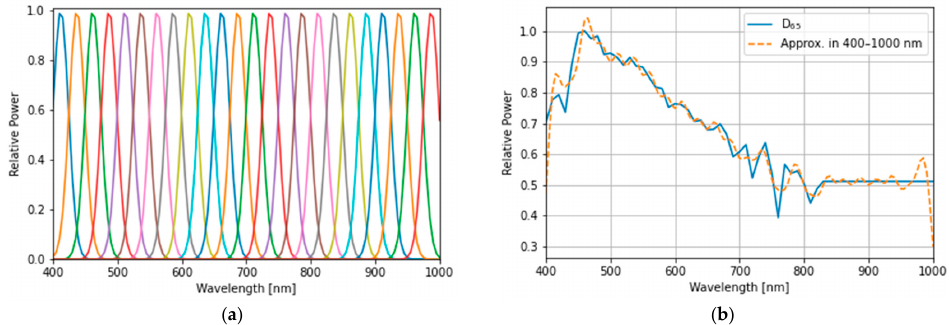
Figure 6. Sets of SPDs with real light-emitting diodes (LEDs): ( a ) measured SPD of 24 LEDs for sub- lights, and ( b ) approximation of an SPD of D65 standard illumination with SPDs represented in ( a ).